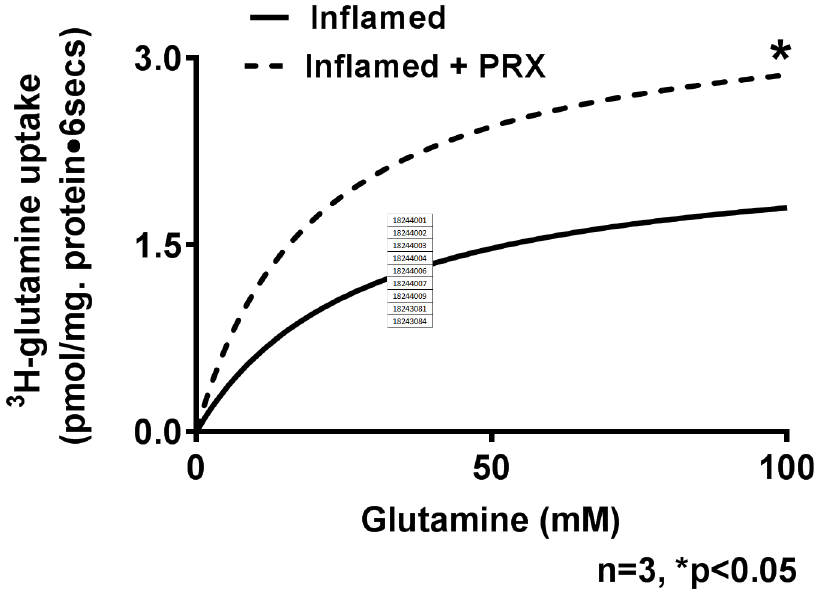
Fig 6. A representative graph of kinetics of glutamine uptake in inflamed and inflamed+PRX villus BBMV. The kinetic parameters derived from an n = 3 of such experiments are shown in Table 2.